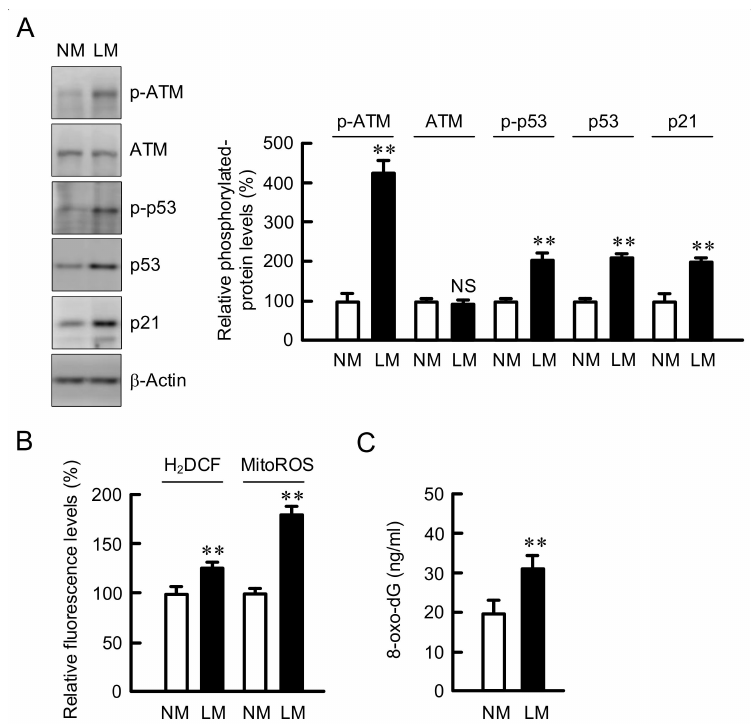
Figure 2. Effects of LM on cell cycle regulators, ROS production, and oxidative-DNA damage. A549 cells were continuously cultured in the media containing NM or LM. ( A ) Western blotting was performed using anti-p-ATM, anti-ATM, anti-p-p53, anti-p53, anti-p21, and anti- β -actin antibodies. The expression levels of these proteins were corrected by β -actin and are represented in percentage to NM. ( B ) The cells were incubated with Hoechst33342 plus H 2 DCFAM or MitoROS for 30 min. The relative fluorescence intensities of H 2 DCF and MitoROS were represented as percentage of NM. ( C ) The content of 8-oxo-dG was examined using DNA damage (8-oxo-dG) ELISA kit and calculated using calibration curve. n = 3–8. ** p < 0.01 compared with NM. NS, p > 0.05.